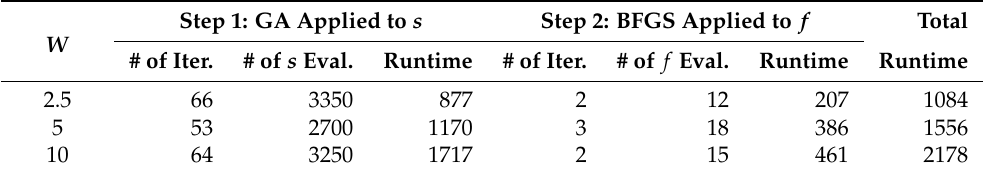
Table 4. The runtimes, iteration counts, and numbers of function evaluations entailed by the hybrid method for the case of a single helix and three sizes of the flow meter (7): W = 2.5, 5, and 10. (Forty-eight computer cores are used). Step 1: GA Applied to s Step 2: BFGS Applied to f Total W # of Iter. # of s Eval. # of Iter. # of f Eval.